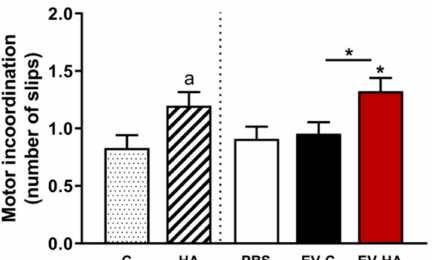
Figure 8. Vesicles isolated from plasma of hyperammonemic rats produce motor incoordination in control rats. Number of slips measured in Beam Walking test. One-way ANOVA with Tukey post-hoc test was performed to compare PBS, EV-C, and EV-HA groups. Values are the mean ± SEM of 19–22 rats per group. Values significantly di ff erent from PBS or EV-C group are indicated by asterisk (* p < 0.05). Number of slips from control (C) and hyperammonemic rats (HA) without injection are